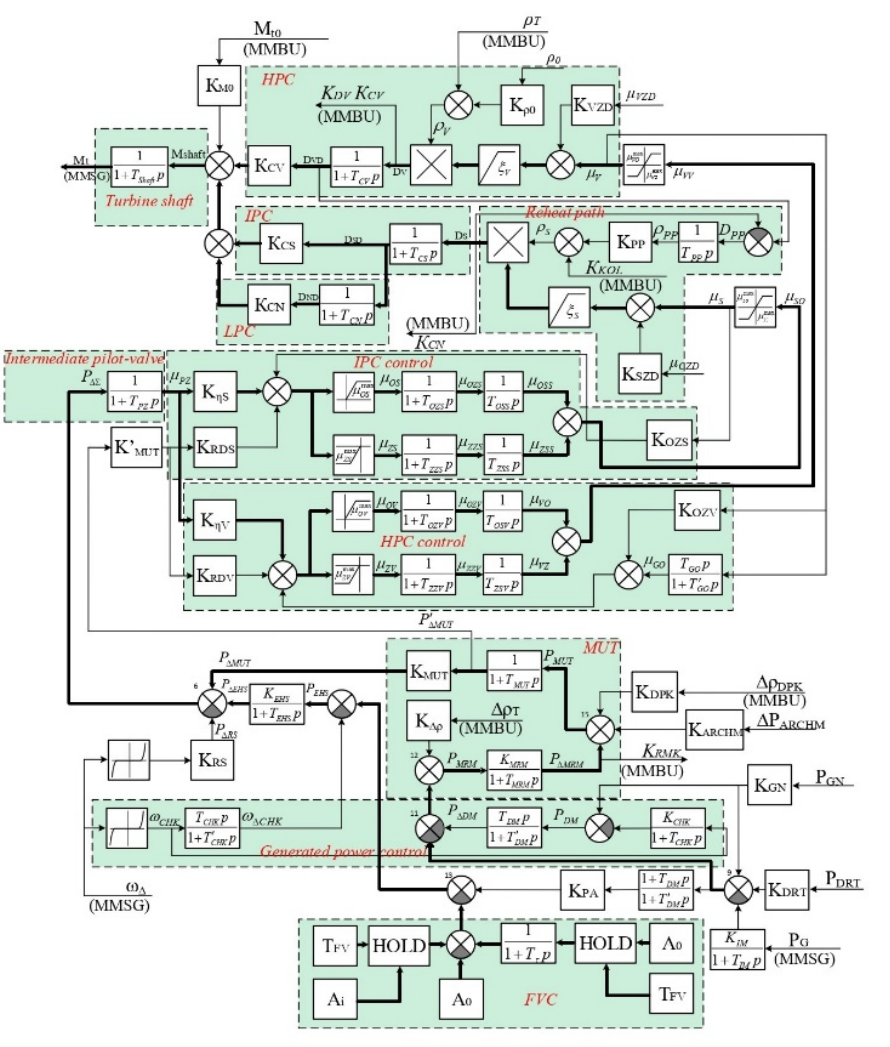
Figure 6. Mathematical model of a steam turbine.